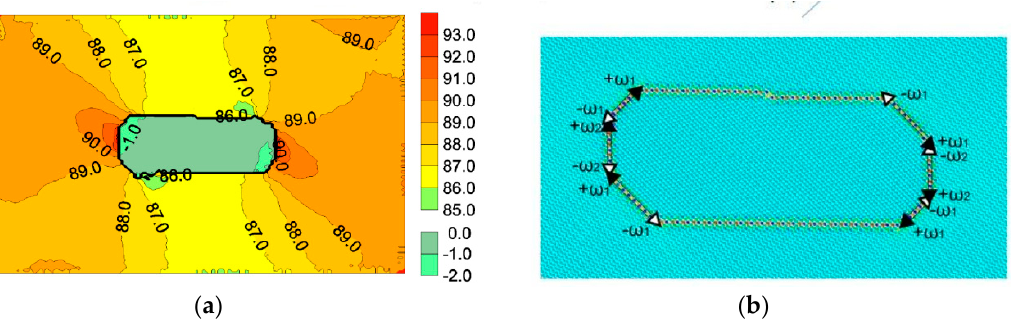
Figure 12. Variation of misorientation around faceted twin core. Distribution of lattice misorientation angle relative to the center of core ( a ) and scheme of disclinations located in the facet junctions ( b ). (Reproduced from [53], with permission from Taylor & Francis Ltd., 2014).